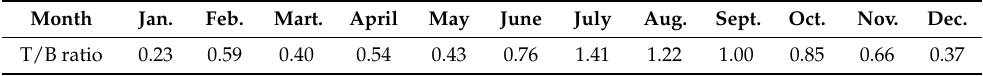
Table 1. The T/B ratios over the year in the ambient atmosphere in Arad City.